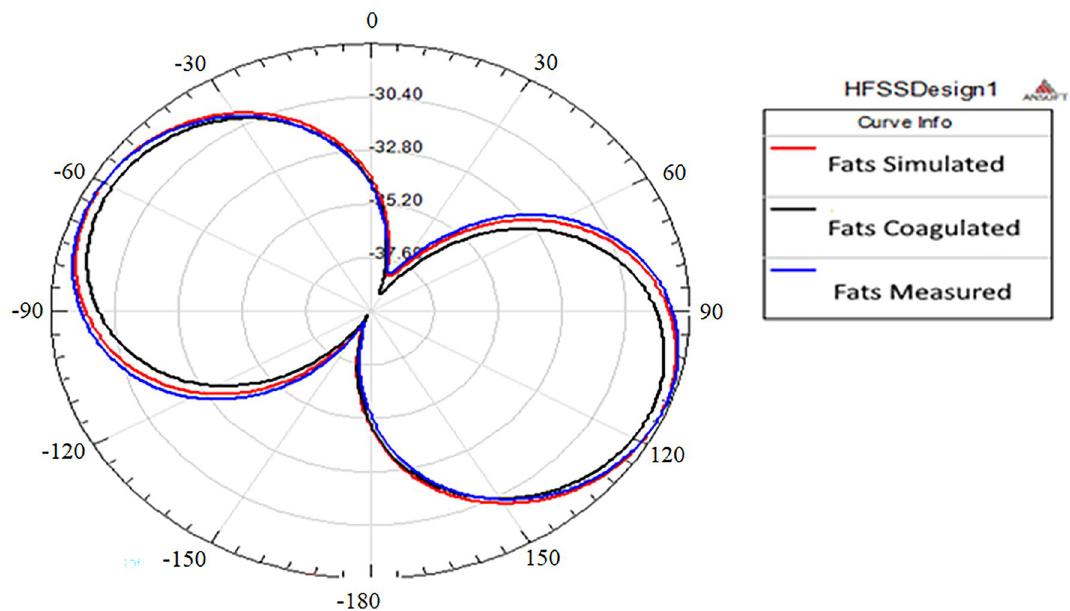
Figure 10. The gain of the proposed